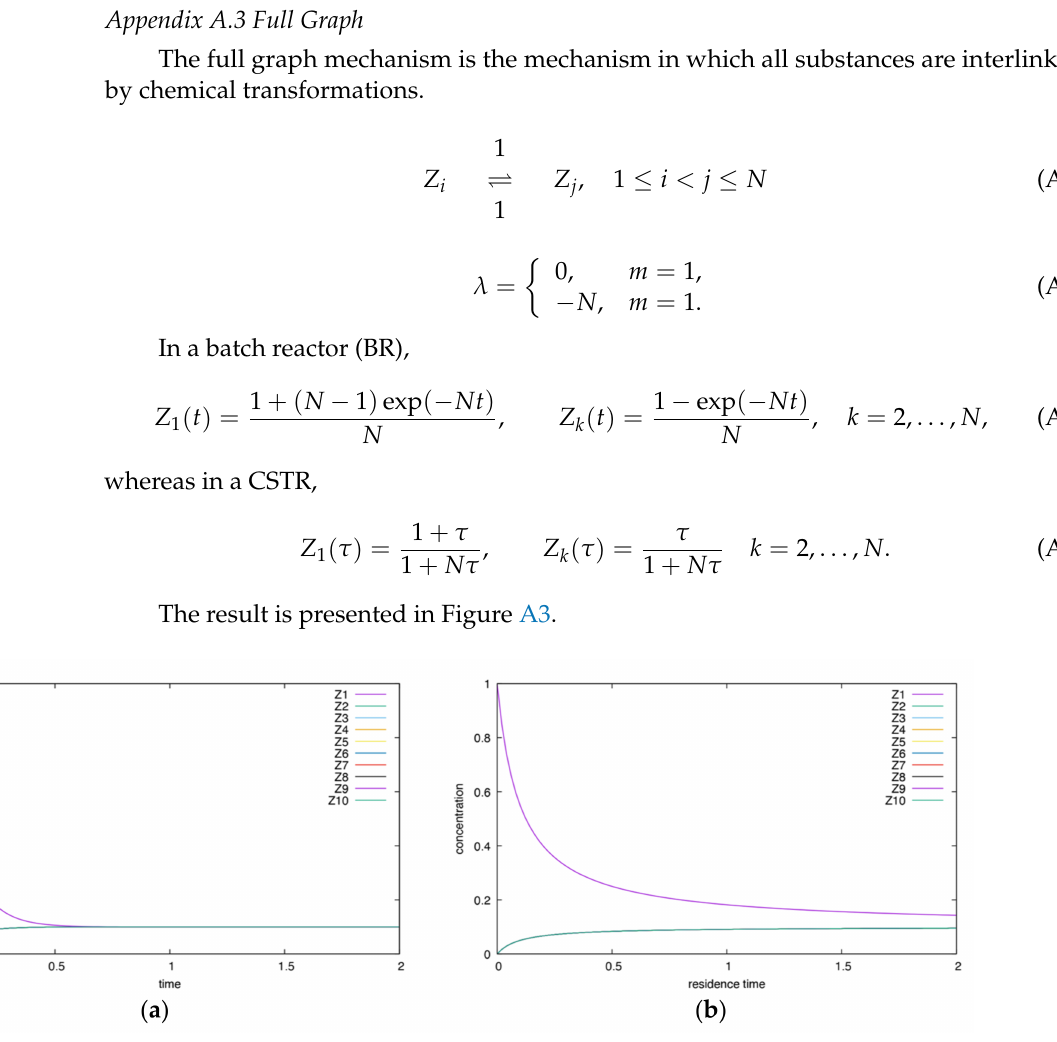
Figure A3. Evolutions in a BR ( a ) and in a CSTR ( b ) of the full mechanism, N = 10. The concentrations of Z2 to Z10